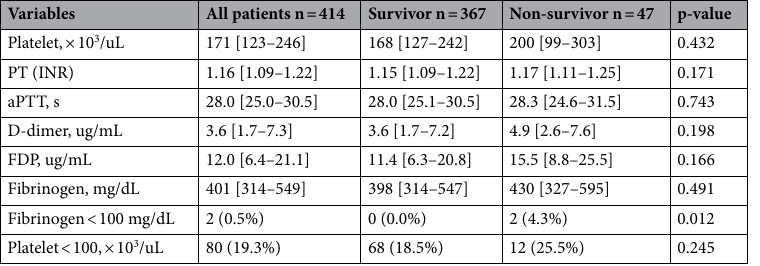
Table 2. Comparison of the coagulation profile in each group. Values are expressed as the median [interquartile range] or number (%). PT prothrombin time; INR international normalized ratio; aPTT